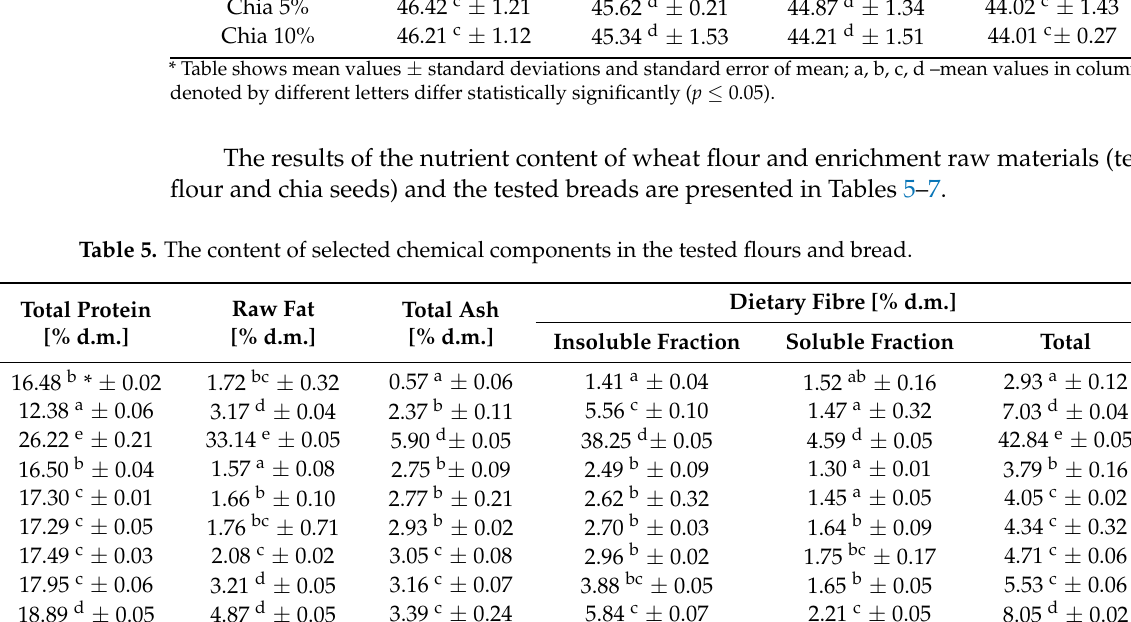
* Table shows mean values ± standard deviations and standard error of mean; a, b, c, d, e –mean values in columns denoted by different letters differ statistically significantly ( p ≤ 0.05). Table 6. The content of selected macronutrients in the tested flours and bread.